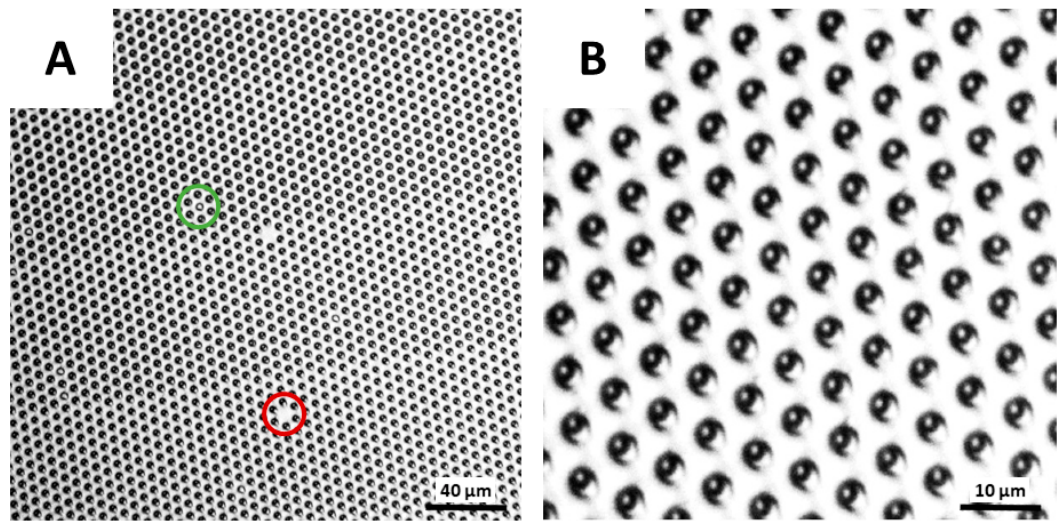
Figure 10. Bright-field microscopy images of seeding superparamagnetic beads in microwells. Seeding efficiency of 99.6% in HIH microwells, fabricated through the proposed fabrication procedure (Procedure VII) with ( A ) 40 × and ( B ) 65 × magnification. The green circle indicates an empty well (i.e., microwell without bead), while the red circle indicates a defect in the array (i.e., absent microwell).